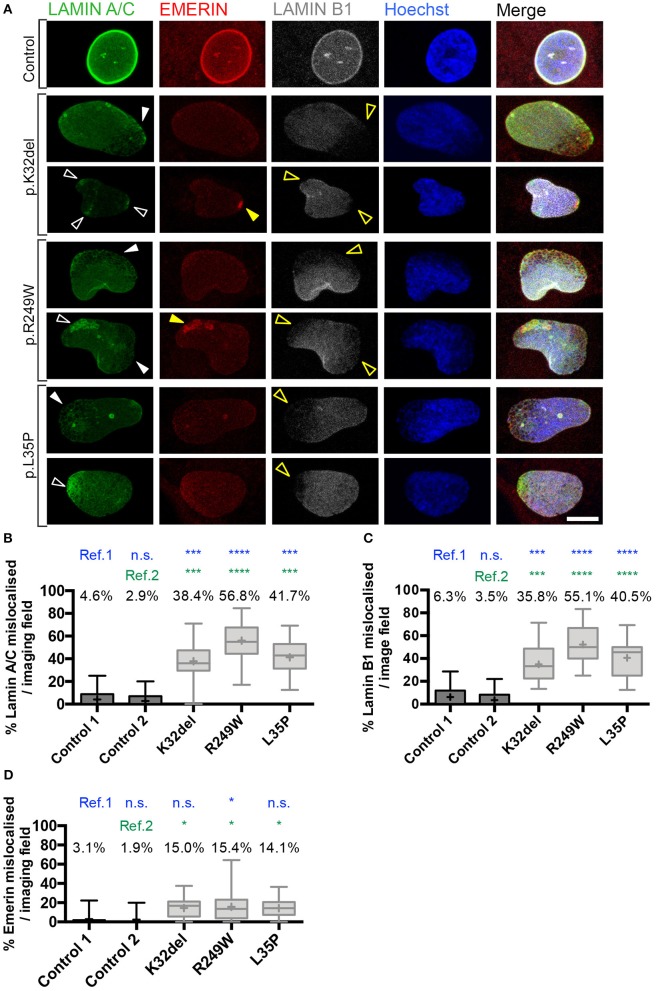
Confocal microscopy analysis in LMNA-mutant human iPSC-derived inducible myogenic cells shows mislocalization of Lamin A/C and Lamin B1. (A) Immunofluorescence for Lamin A/C, Emerin and Lamin B1 with Hoechst nuclear counterstain, showing aggregates of Lamin A/C protein in K32del, R249W, and L35P LMNA-mutant lines using analysis by confocal microscopy. Aggregates were either honeycomb-like in appearance (white closed arrow) or bright foci (white open arrow). Areas with Lamin A/C honeycombs/foci display a corresponding lack of Lamin B1 (yellow open arrows). Emerin-containing foci were also detected in some areas containing Lamin A/C foci (yellow closed arrow), however areas with honeycombs of Lamin A/C did not have observable corresponding honeycombs of Emerin, however Emerin immunolabeling was weak and so may be unable to detect honeycombing. Scale bar represents 10 μm. (B) Quantification of the proportion of LMNA-mutant HIDEMs with mislocalization of Lamin A/C. All LMNA-mutant HIDEMs had significantly more aggregates of Lamin A/C than each control cell line (ref.1 and 2) (C)
LMNA-mutant HIDEMs had a significantly higher proportion of nuclei with Lamin B1 capping (absence at poles of nuclei) compared to control (ref.1 and 2). (D) Emerin mislocalization was significant for K32del or L35P in comparison to control 2 (ref.2) but not to control 1 (ref.1). In R249W it was significant compared to both control 1 and 2 (ref.1 and 2). We therefore judged overall this phenotype was only robust in R249W. Lamin A/C, Lamin B1 and Emerin data were statistically analyzed together using one-way analysis of co-variance (ANOVA), with Tukey's post-hoc comparisons. This analysis was performed on the average proportion of mislocalized from three passages per cell line (n = 3, between 82–178 cells analyzed per passage per cell line); *p < 0.05, ***p < 0.001, ****p < 0.0001 compared to each control. Data are box plots generated from the proportion of nuclei with mislocalized Lamin A/C per imaging field (24–33 imaging fields per cell line combined from three repeats, together containing 290–429 nuclei); whiskers: minimum and maximum values, +: average of all imaging fields.